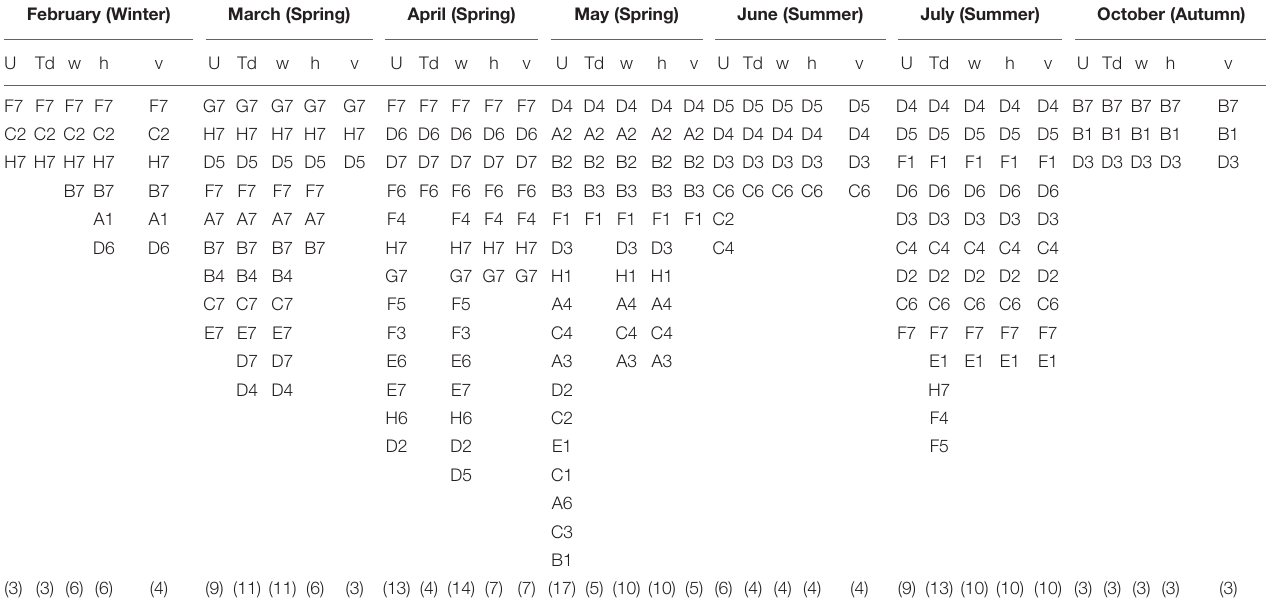
TABLE 4 | Seasonal variation in optimal sensor